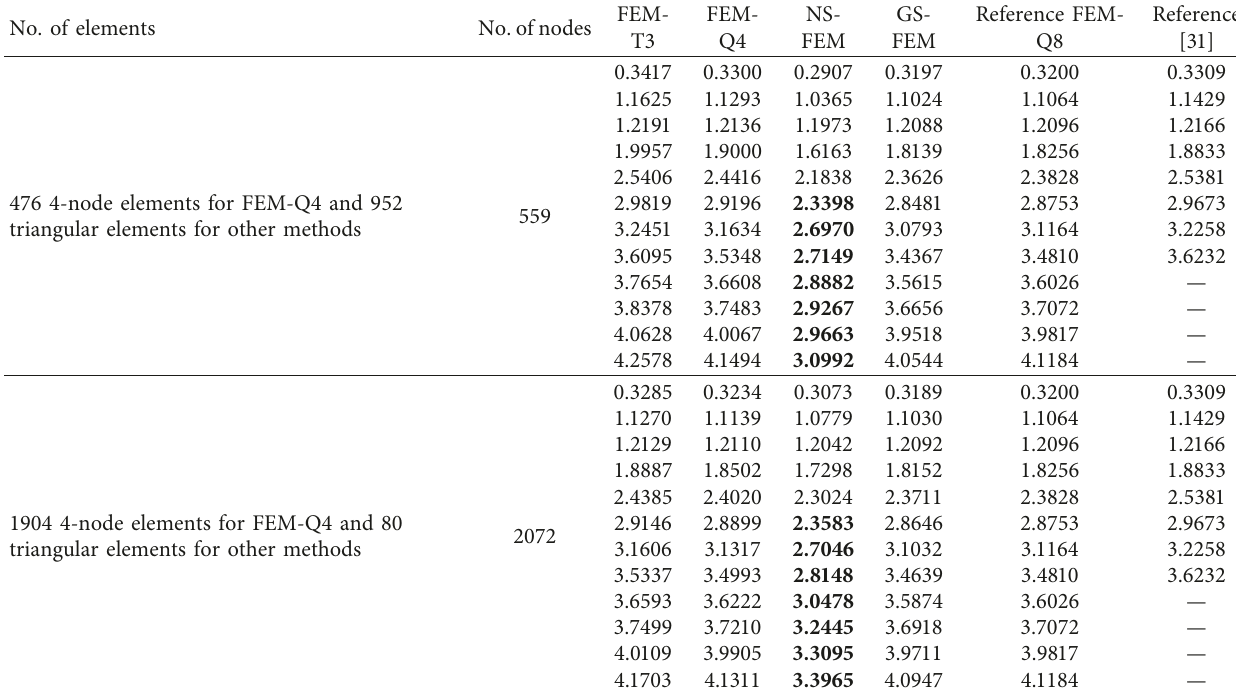
Figure 25: Domain discretization using triangular and quadrilateral elements. Table 3: First 12 natural frequencies ( × 104Hz) of shear